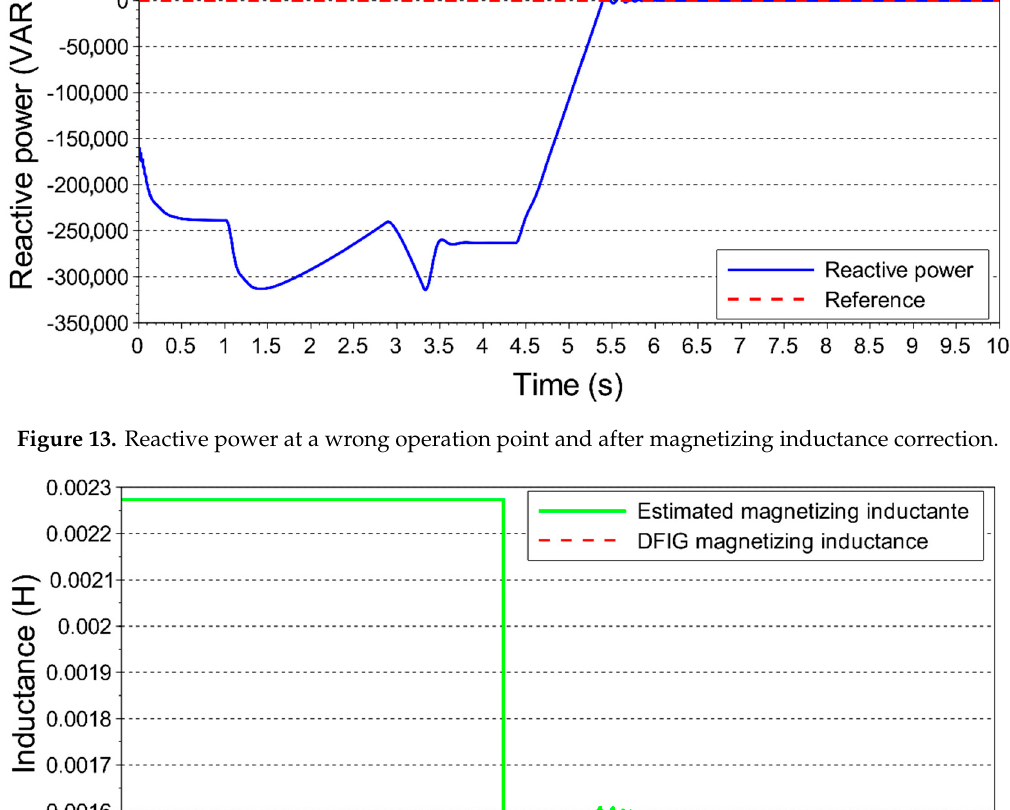
Figure 13. Reactive power at a wrong operation point and after magnetizing inductance correction.